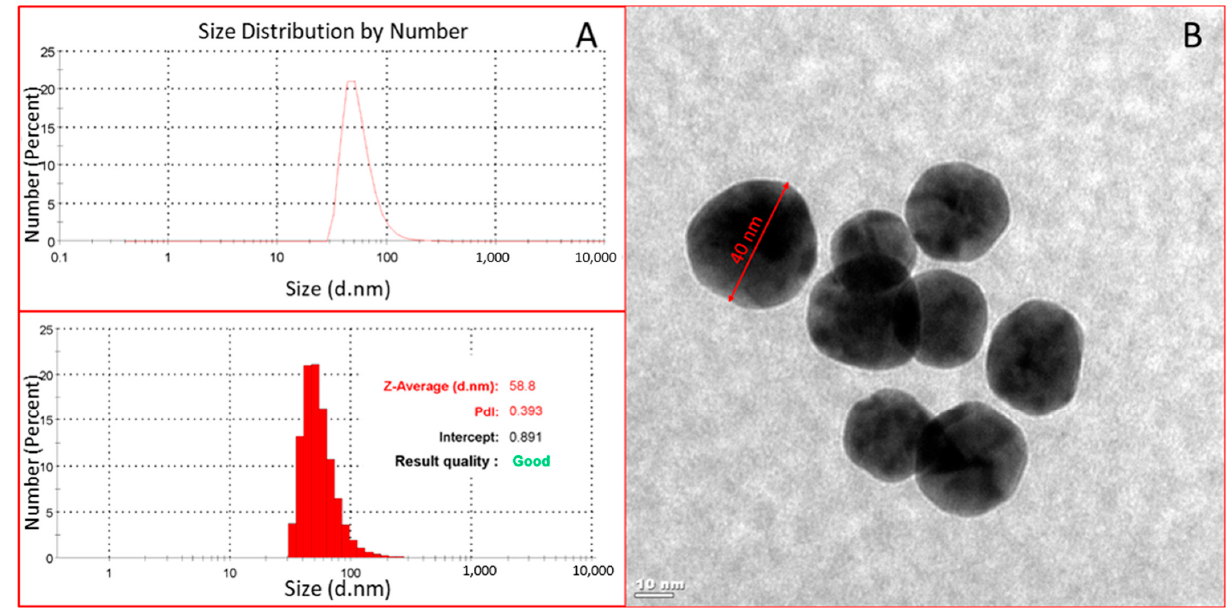
Figure 1. DLS analysis ( A ) and TEM image ( B ) of AuNP to obtain size distribution and